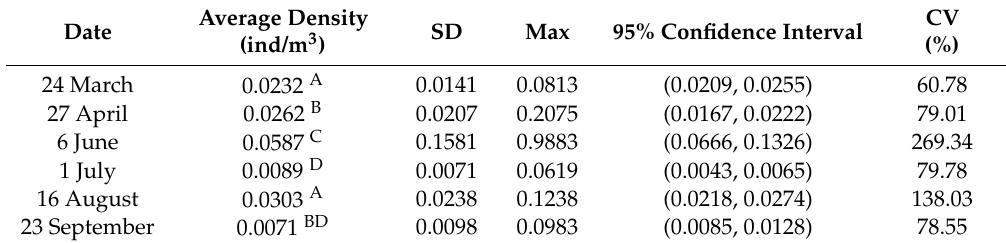
Table 2. Distribution of fish density in different months, from hydroacoustic surveys in 2016.